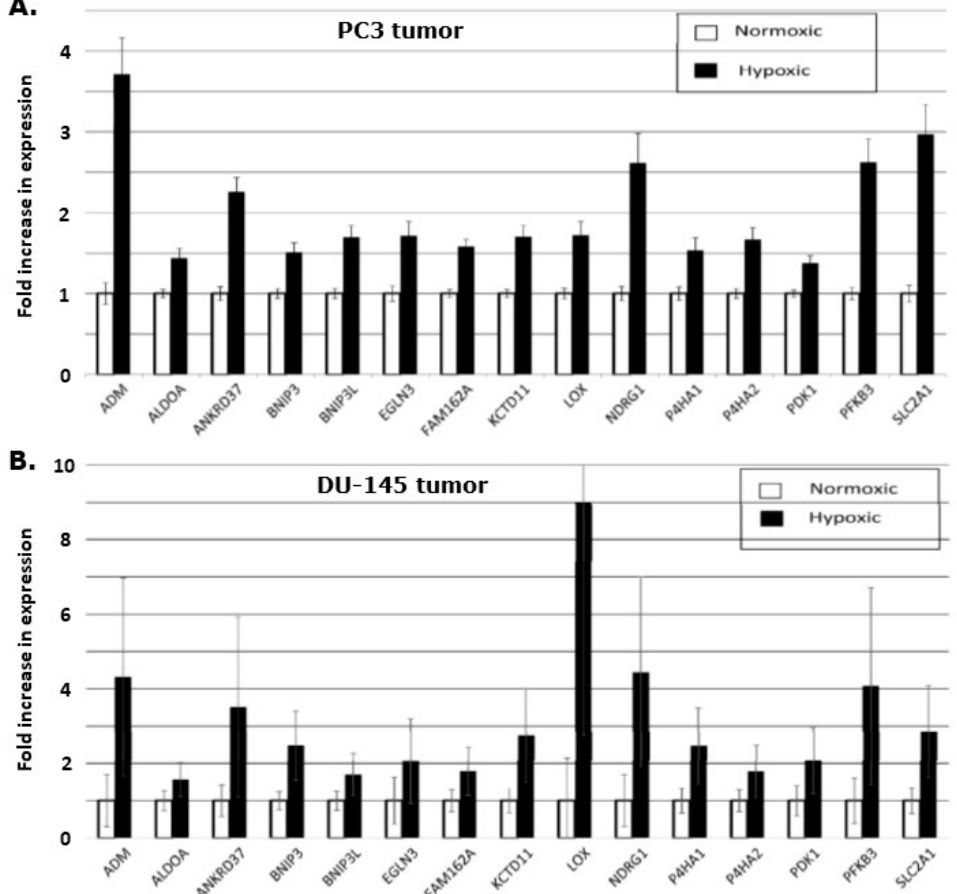
Figure 5. Relative in vivo expression of the 15 hypoxia genes in hypoxic areas when compared to measurements made in non ‐ hypoxic areas. Results are for PC3 ( A ) or DU ‐ 145 ( B ) flank xenografts. For the PC3 tumors, the results are based on 43 samples from non ‐ hypoxic areas and 33 samples from hypoxic areas distributed over 17 tumors in nine animals (one animal only had one flank tumor). The results for the DU ‐ 145 xenografts consisted of 34 samples from non ‐ hypoxic areas and 43 samples from hypoxic areas (from a total of 12 flank tumors in eight mice). All values are listed as means ± 1 S.E.